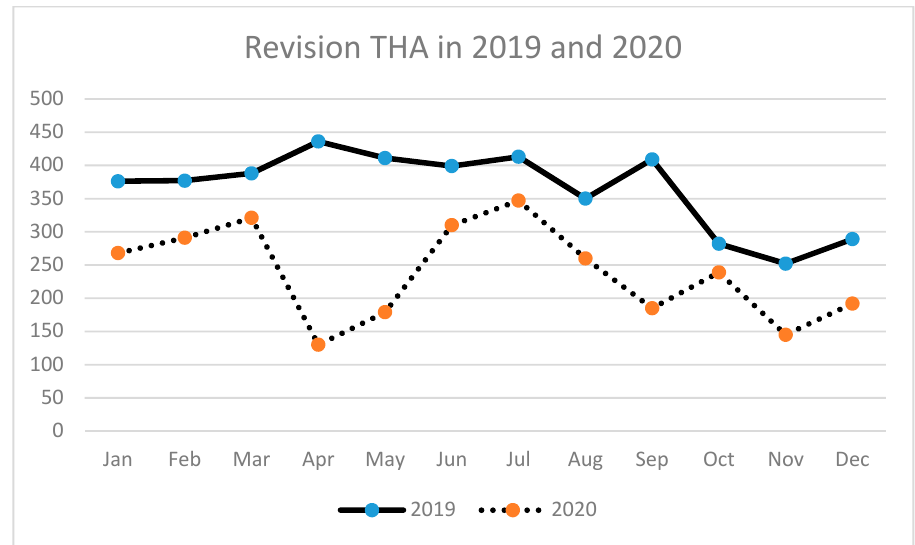
Int. J. Environ. Res. Public Health 2021 , 18 , x FOR PEER REVIEW 5 of 10 Figure 3. Number of primary total hip arthroplasties (THA) performed in the particular months of 2019 and 2020 in Poland.